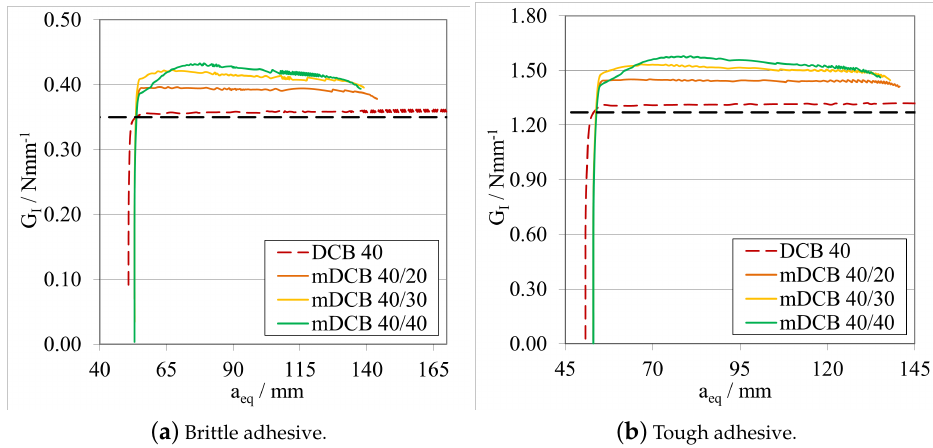
Figure 22. R-curves related to a 0 ELS ≤ a 0 mDCB , compared against the correspondent standard DCB. Black dashed line represents the input G IC value.